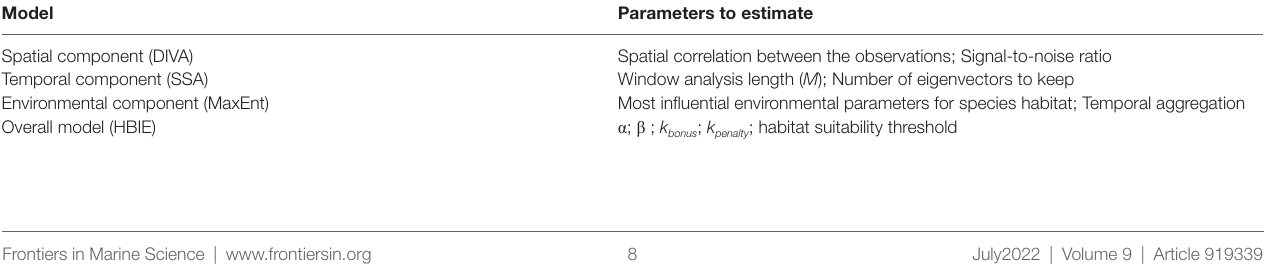
TABLE 1 | Complete set of parameters used by our models and optimised in the training phase. Model Parameters to